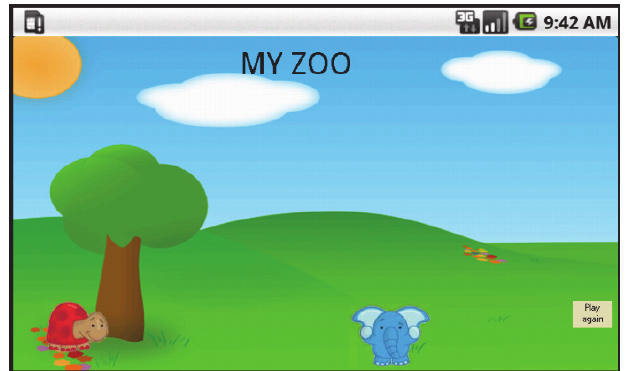
Figure 6 . The zoo screen where children are rewarded for their work in the game In total there were nine animals that could be bought for the zoo ranging from a snail for 50 points and a tiger for 115. The game as described was implemented in Java, installed on Android tablets and taken to Uganda in Africa for children to